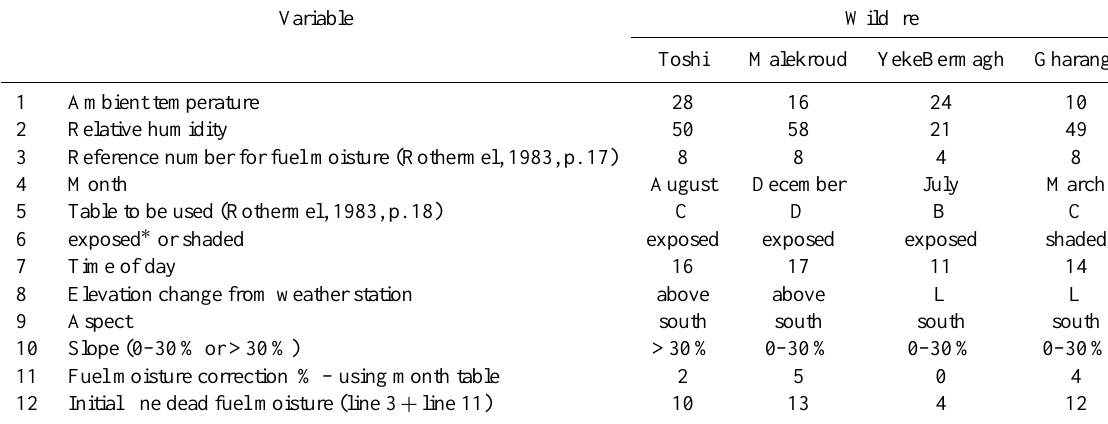
Table A1. Data used for calculating initial dead fuel moisture content (FMC) for the wildfire case studies. The FMC values were calculated according to the method proposed by Rothermel (1983).